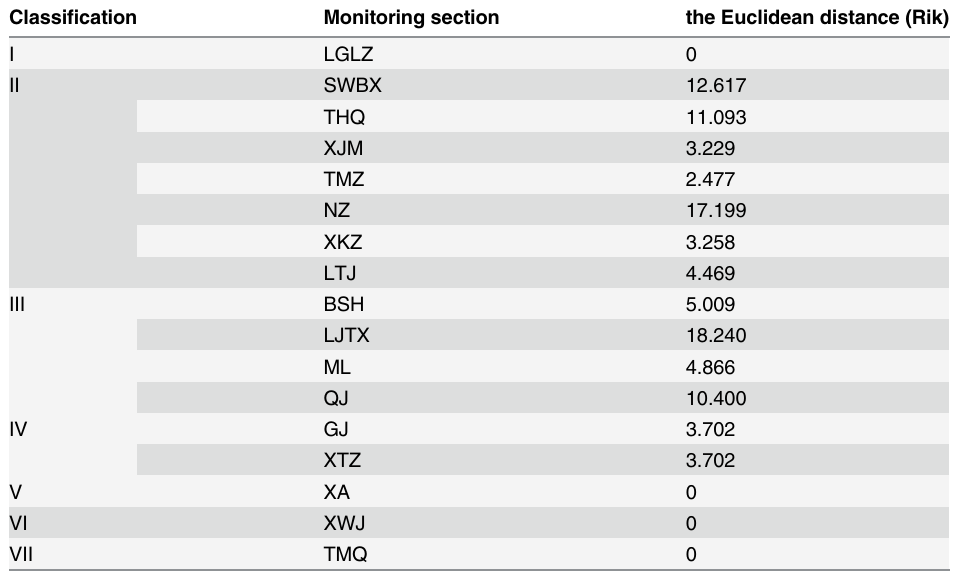
Table 5. The Euclidean distance (R ik ) between the section and the center of gravity of its